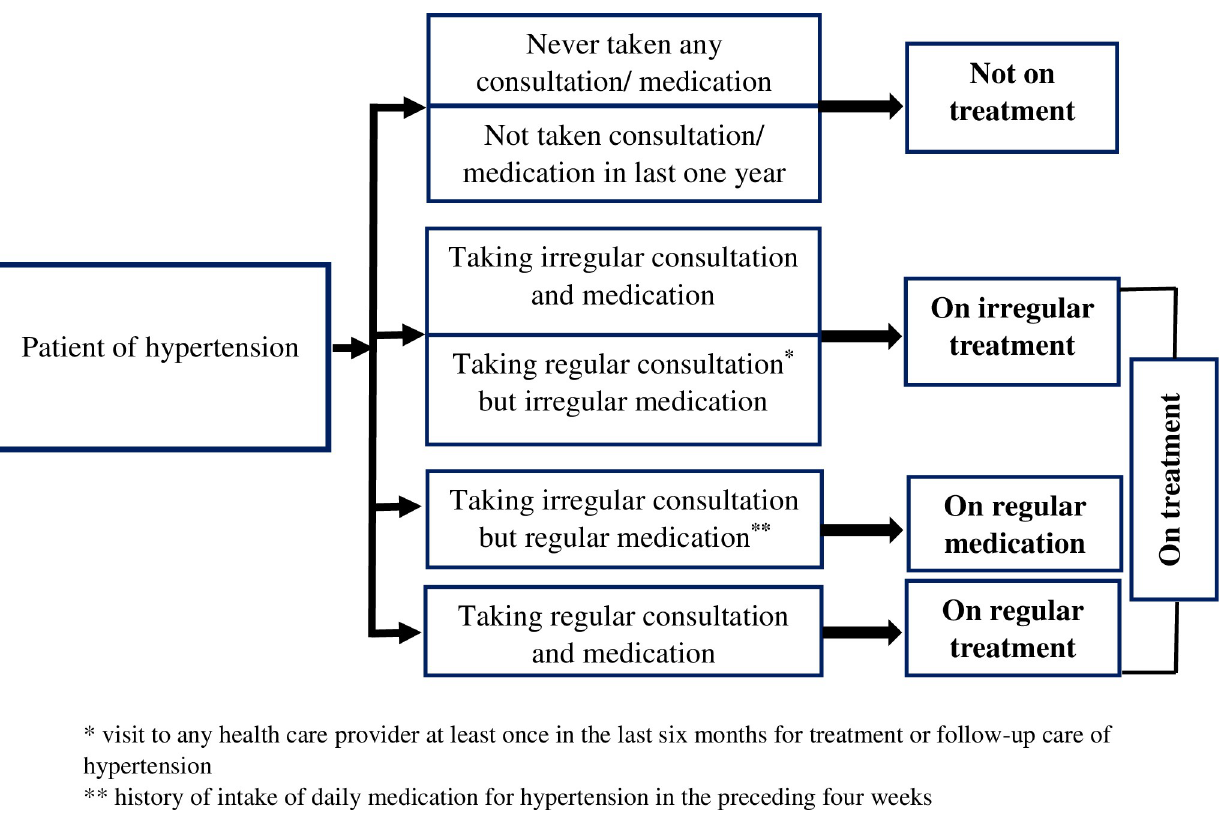
Fig 1. Construct of health care seeking behaviour for hypertension among the